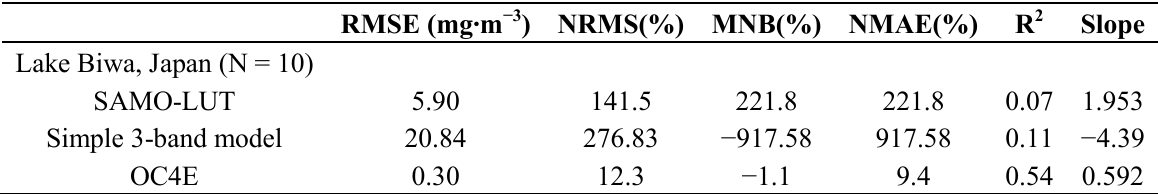
Table 6. Performance of the SAMO-LUT, Simple 3-band Model and OC4E for the estimation of Chl- a in Lake Suwa,